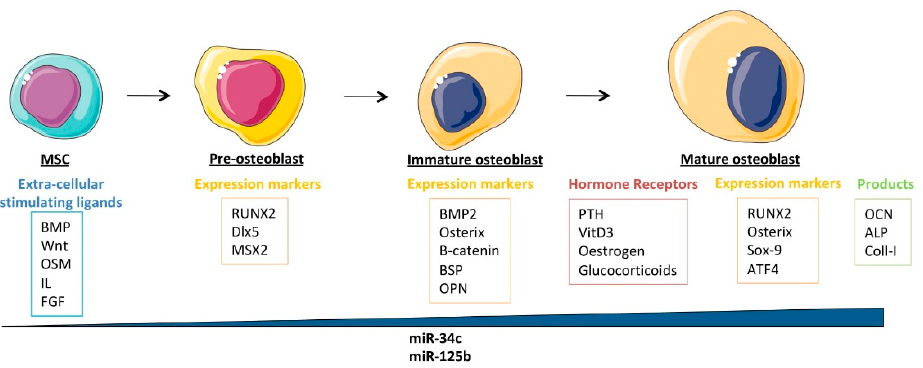
Figure 2. The osteoblastic-differentiation process; ALP : alkaline phosphatase; ATF4 : activating transcription factor 4; BMP : bone morphogenetic protein; BSP : bone sialoprotein; Coll-I : type I collagen; FGF : fibroblast growth factor; IL : interleukin; MSC : mesenchymal stem cells; MSX2 : Msh homeobox 2; OCN : osteocalcin; OPN : osteopontin; OSM : oncostatin M; PTH : parathormone; RUNX2 : runt-related transcription factor 2. The blue triangle represents the increased miRNA-expression level found in the cells during the course of the differentiation.